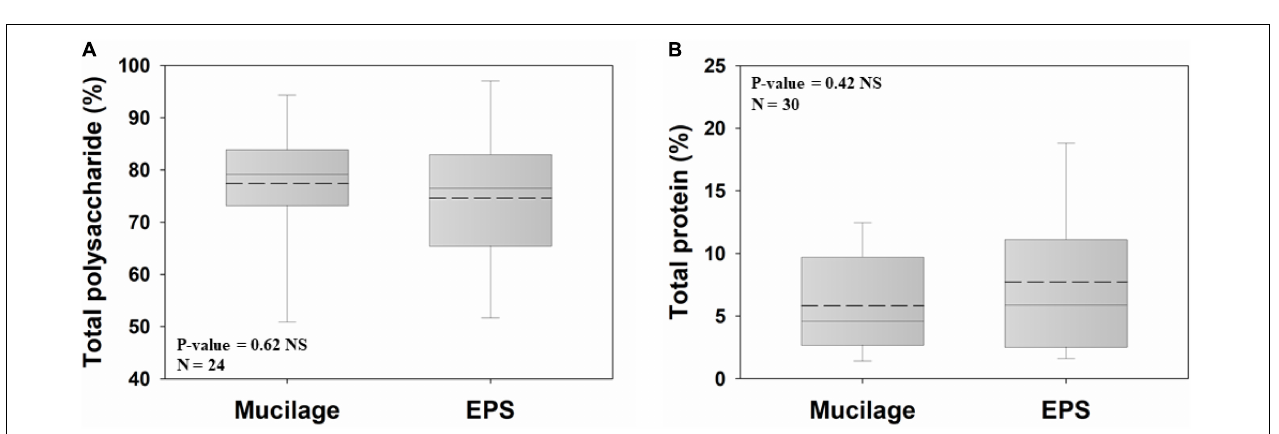
FIGURE 2 | Comparison of mucilage and EPS total polysaccharide (A) and total protein (B) , using Independent Samples t -test at the significance level of 0.05. The dashed and solid lines on each box indicate the arithmetic mean and median, respectively. The box defines the 25th and 75th percentiles. NS, non-significant; N, number of data